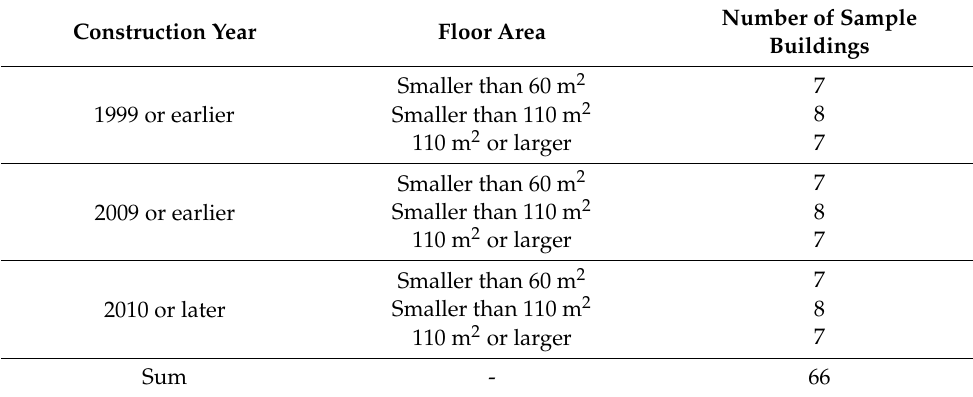
Table 1. Overall sample design of residential buildings.